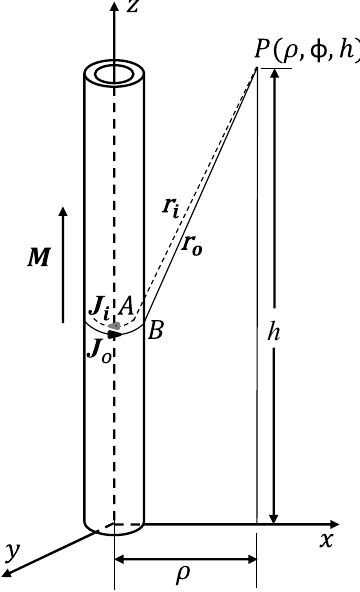
Figure 2. Sketch of an axially magnetized individual casing.